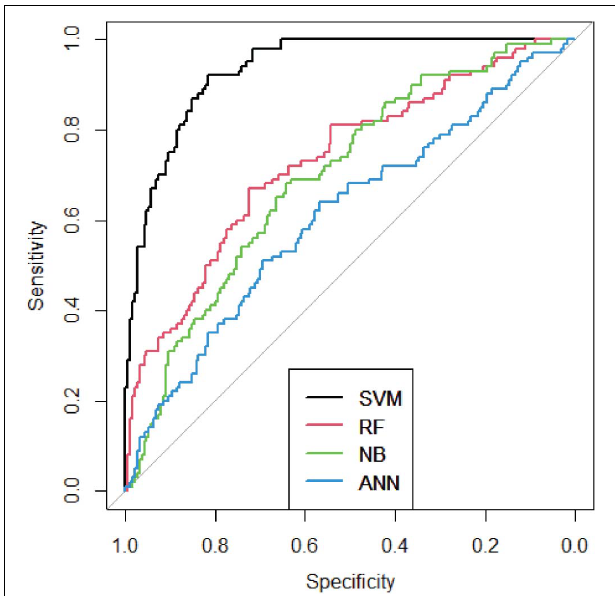
FIGURE 5 | ROC curves of four methods.